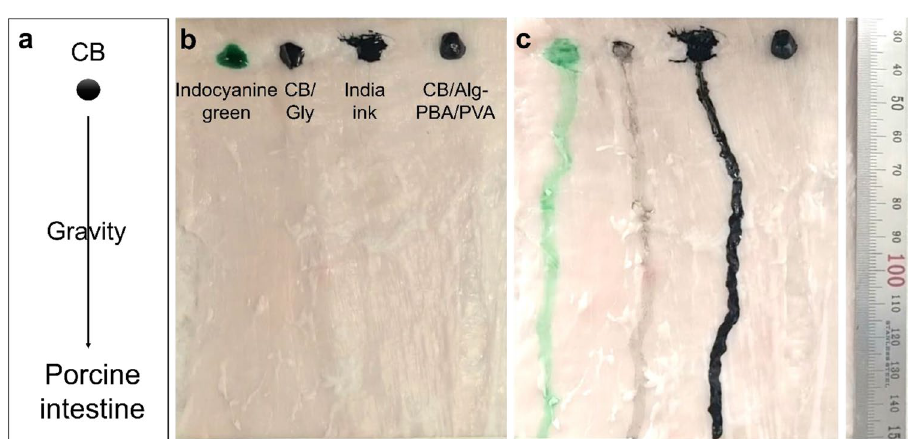
Figure 6. ( a ) Schematic illustrations of immobilization experiments of tattooing materials on porcine intestine. ( b,c ) photographic images of indocyanine green, CB, India ink, and CB/Alg-PBA/PVA hydrogels ( b ) before and ( c ) after